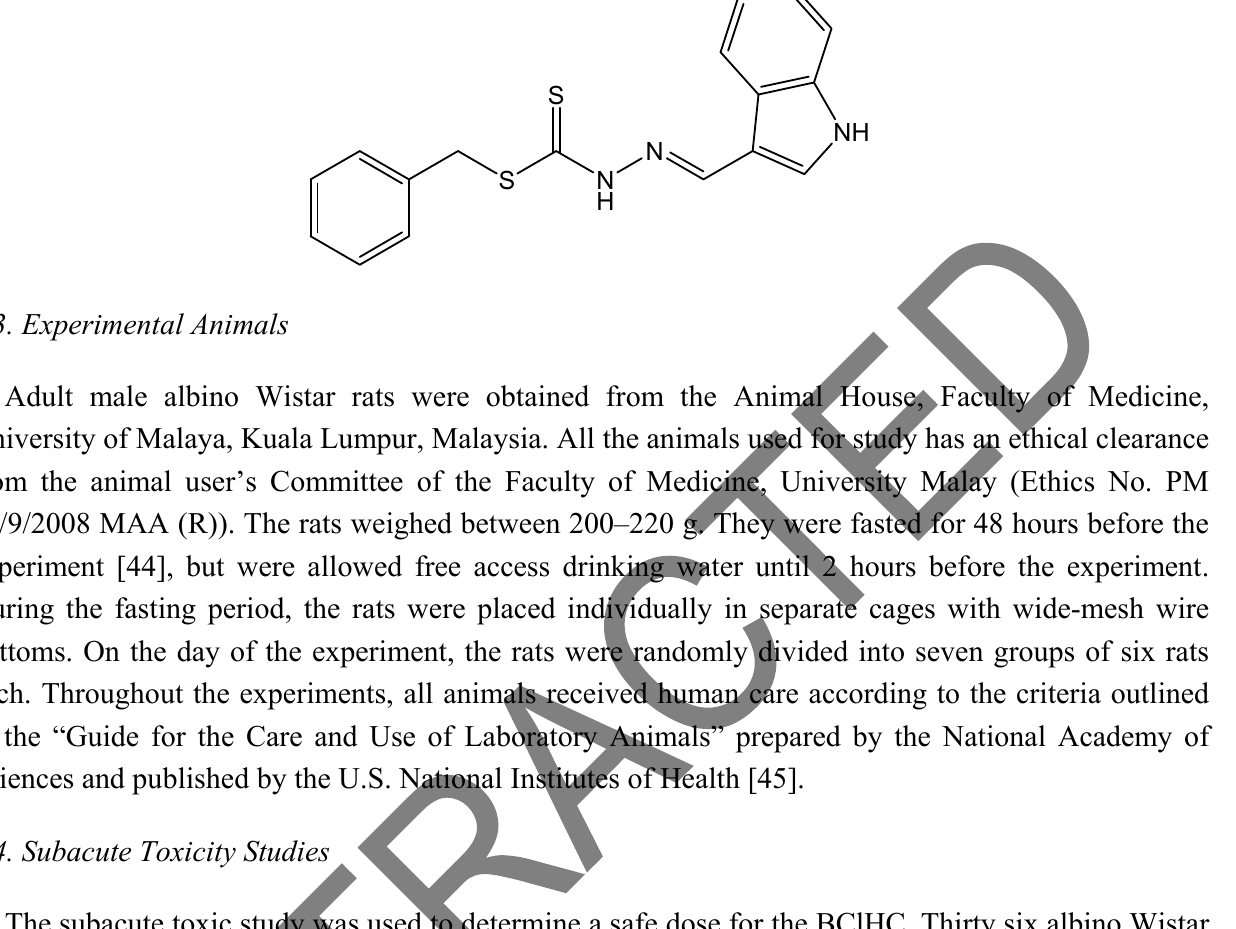
Figure 5. Benzyl N' -(5-chloroindol-3-ylmethylidene)hydrazinecarbodithioate.